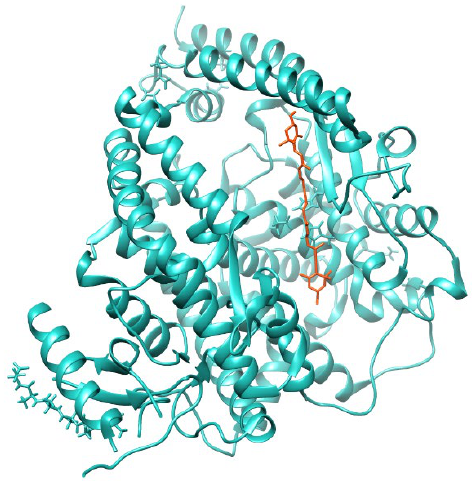
Figure 2. Molecular docking diagrams of diatoxanthin binding to ACE2.